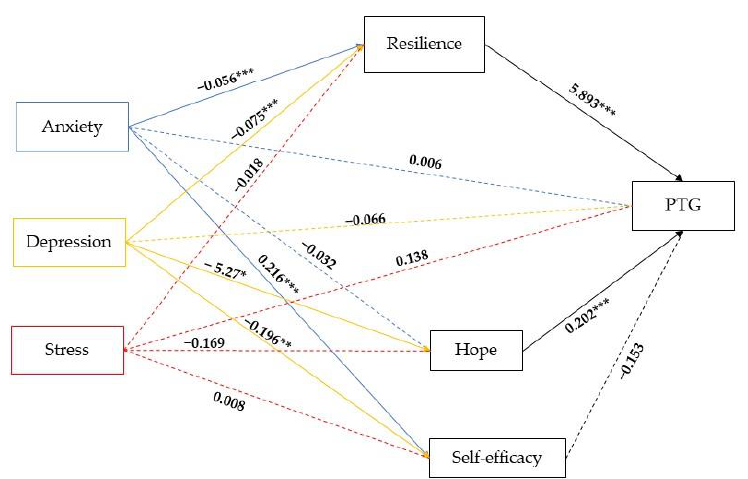
Figure 2. Parallel-multiple mediation of resilience, hope and self-efficacy between symptoms of anxiety, depression and stress, and post-traumatic growth (PTG). Note: * p < 0.05; ** p < 0.01; *** p < 0.001. Dashed lines indicate non-significant effects.